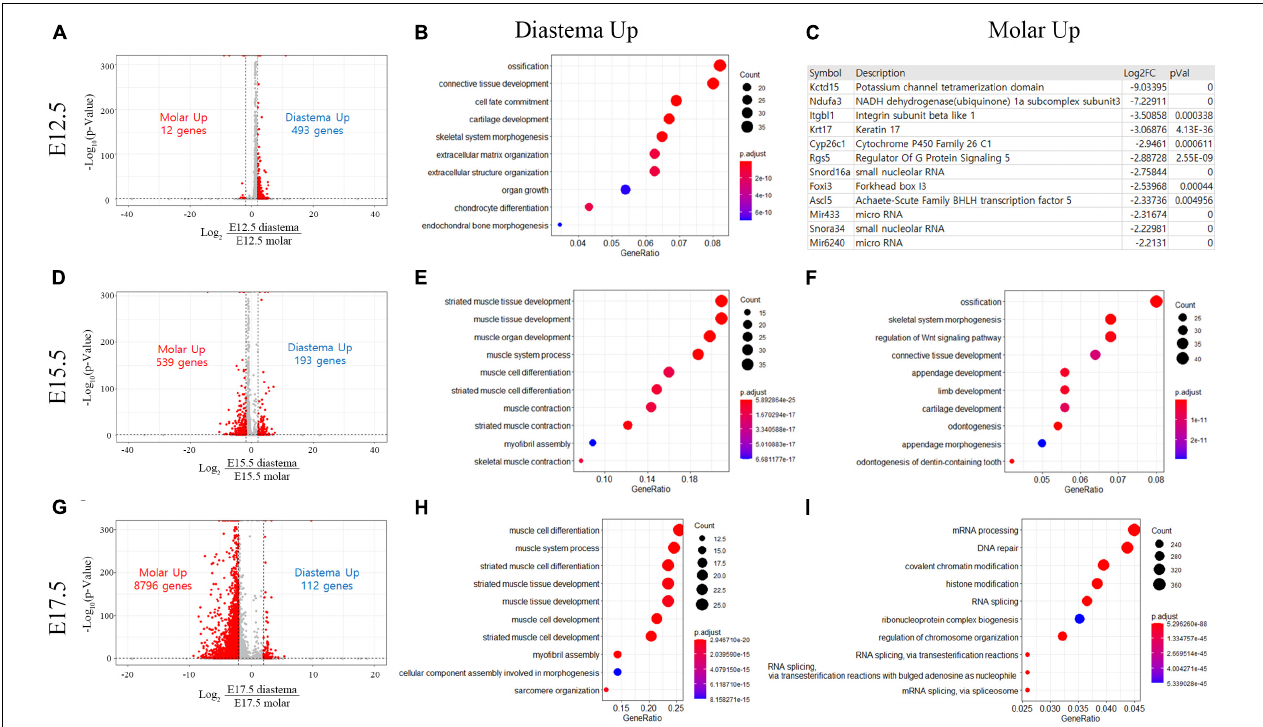
FIGURE 3 | Differentially expressed gene (DEG) and Gene Ontology (GO) analyses of transcriptome in the embryo diastema and molar regions. (A) DEG volcano plot of transcriptome in the E12.5 diastema and molar regions. (B) The top 10 GO terms associated with increased DEG in diastema. The terms of ossification and tissue developments were displayed. (C) Upregulated genes in the E12.5 molar region. (D) DEG plot of transcriptome in the E15.5 embryo. (E,F) The GO terms most indicated in E15.5 diastema and molar. (G) DEG plot of transcriptome in the E17.5 embryo. (H,I) GO terms most indicated in the E17.5 diastema and molar.